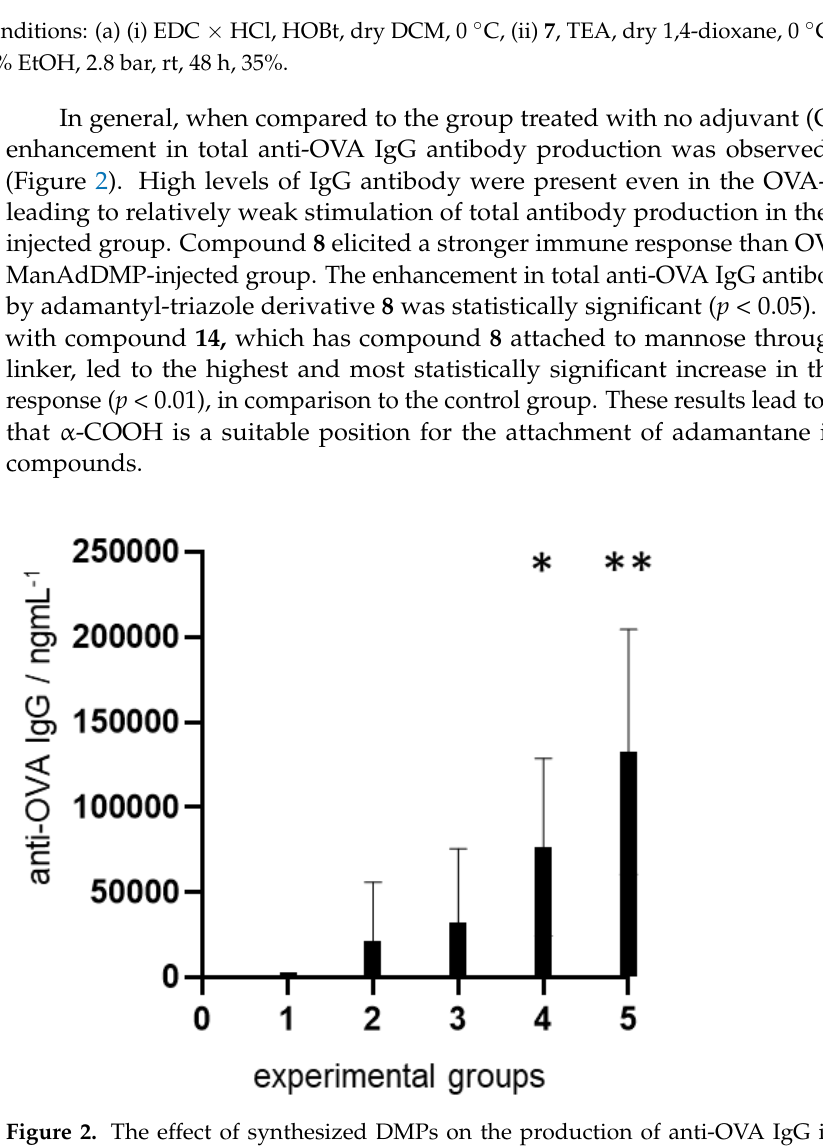
( b ) ( c ) Figure 3. The effect of synthesized DMPs on the production of anti-OVA IgG subtypes: anti-OVA IgG1 ( a ), anti-OVA IgG2a ( b ), and IgG1/IgG2a ratio ( c ), in BALB/c mice immunized with OVA as an antigen. Experimental groups: 1 — control group; 2 — OVA alone; 3 — OVA + ManAdDMP; 4 — OVA + 8 ; 5 — OVA + 14 . Bar graphs represent average values from individual mice from each group ( n = 5). * p < 0.05 and ** p < 0.01 denote statistical significance in comparison to the control